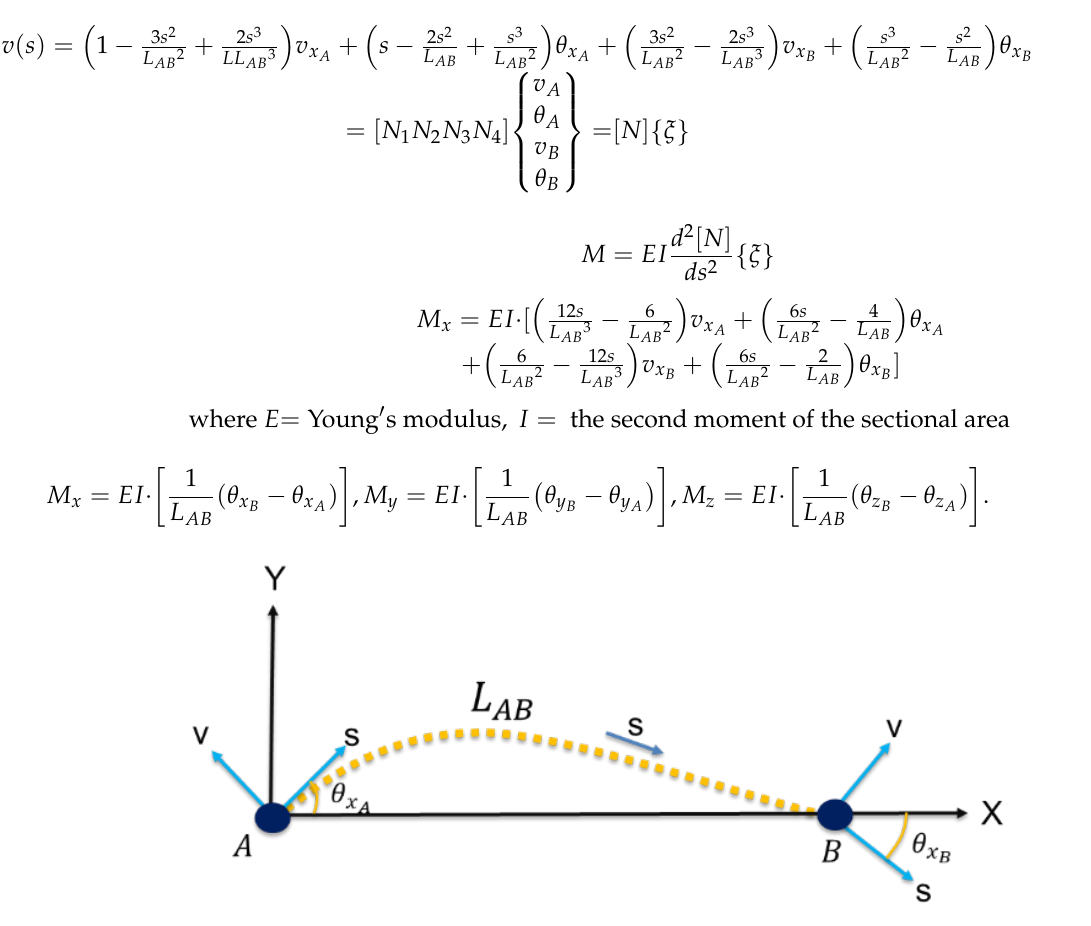
Figure 4. Bending moment estimation model.